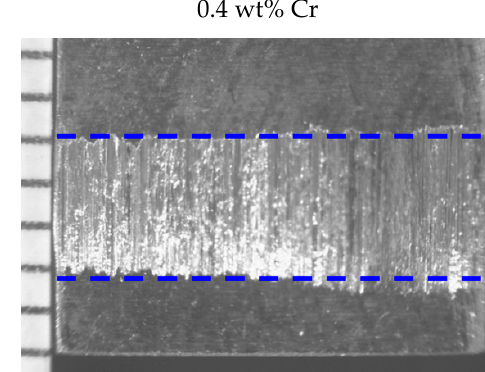
Figure A3. Microstructural evolution for the CADI-0.2Cr-305 sample at the austempering times of 30, 60, 90, and 120 min for the three regions analyzed.